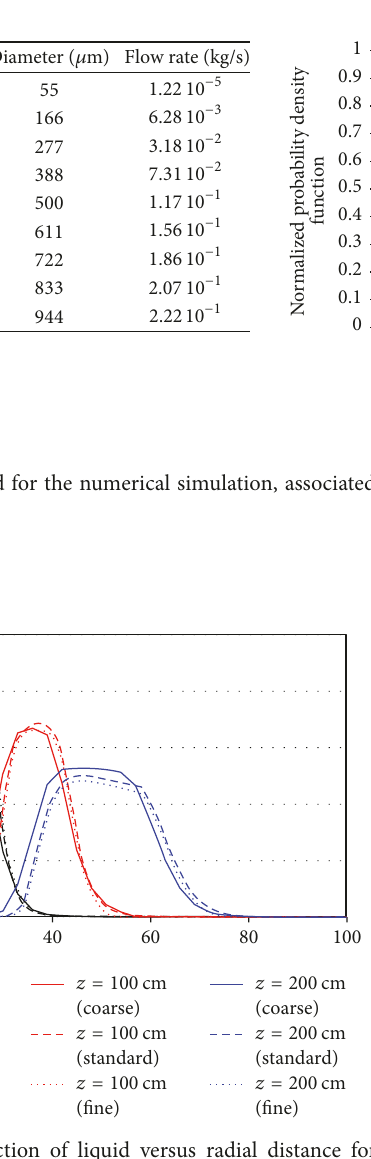
Figure 35: Mean Sauter droplet diameter versus radial distance, polydispersed